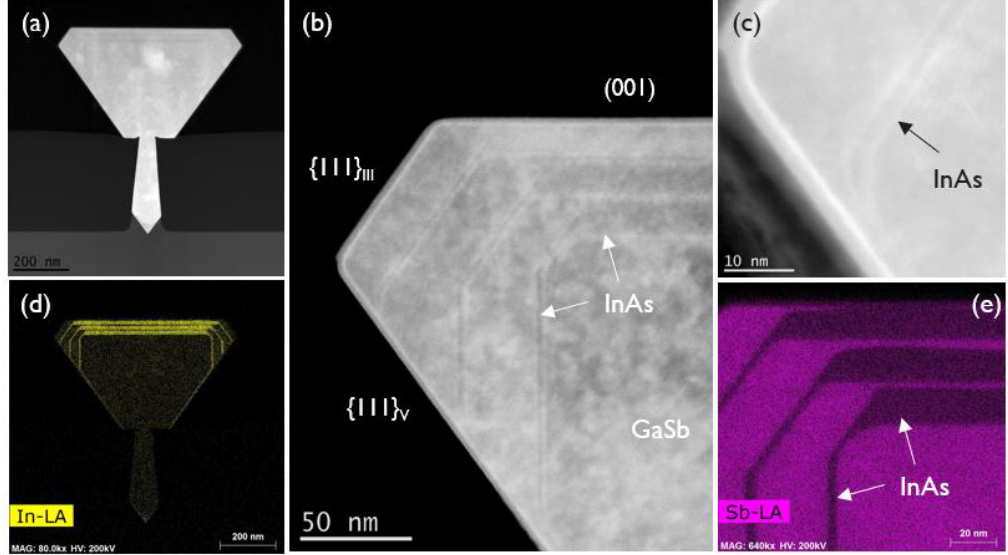
Figure 11. Collection of di ff erent TEM images prepared across the trench orientation of the multi-layer stack deposited at 450 ◦ C. ( a ) is a HAADF-STEM image, ( b ) and ( c ) are DF-STEM images and ( d ) and ( e ) are energy dispersive X-ray spectroscopy (EDS) scans detecting L α energy transition visualizing the presence of In and Sb, respectively. The white spot in figure ( a ) is caused by a local Ga deposition during FIB preparation.